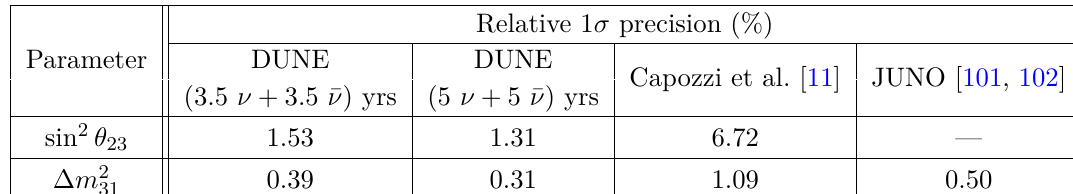
around the true choices sin 2 θ = 0 . 455 and 23 31 from the upcoming JUNO experiment [101, 102] is 31 23